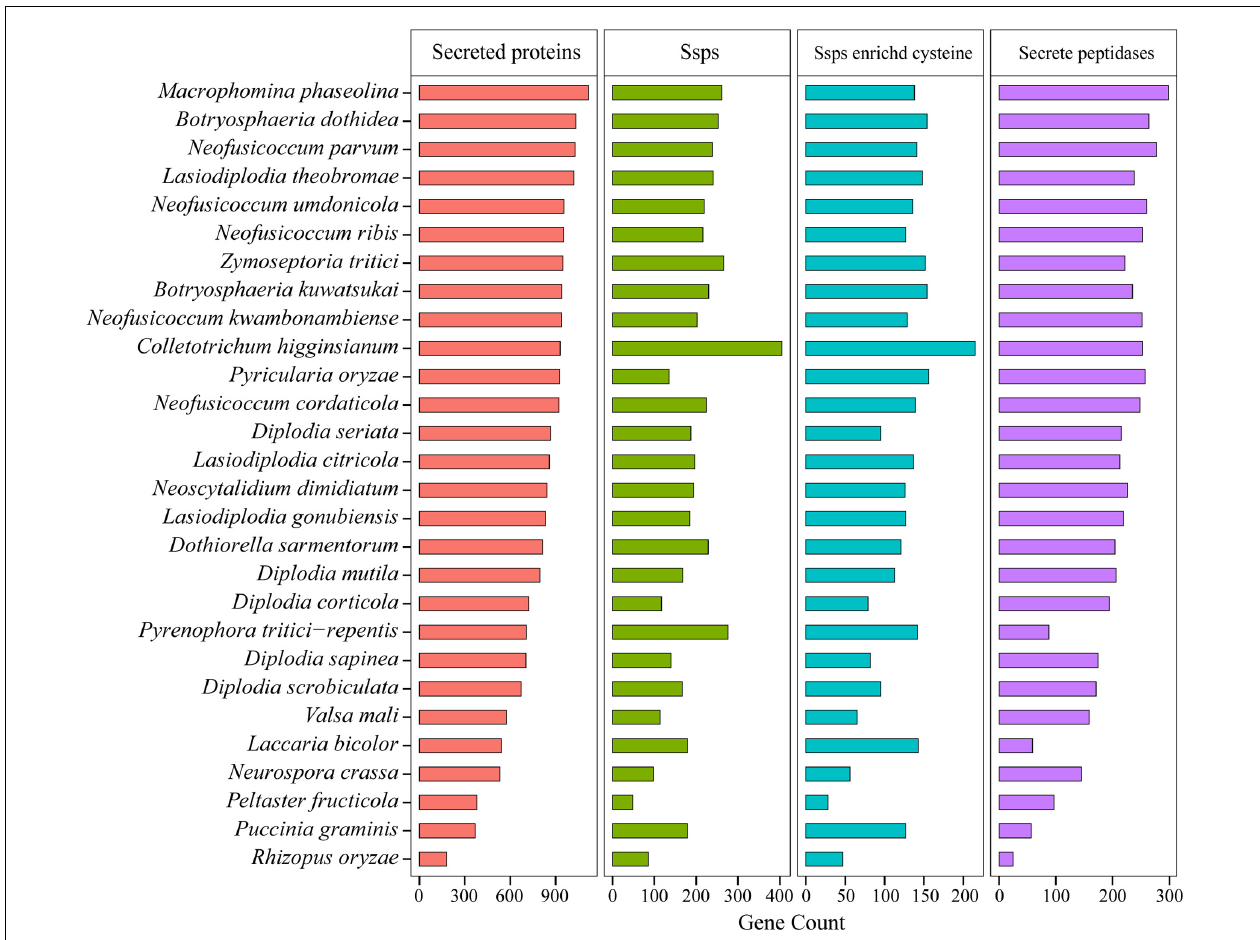
FIGURE 5 | Comparison of secreted proteins among Botryosphaeriaceae fungi and other 10 fungal